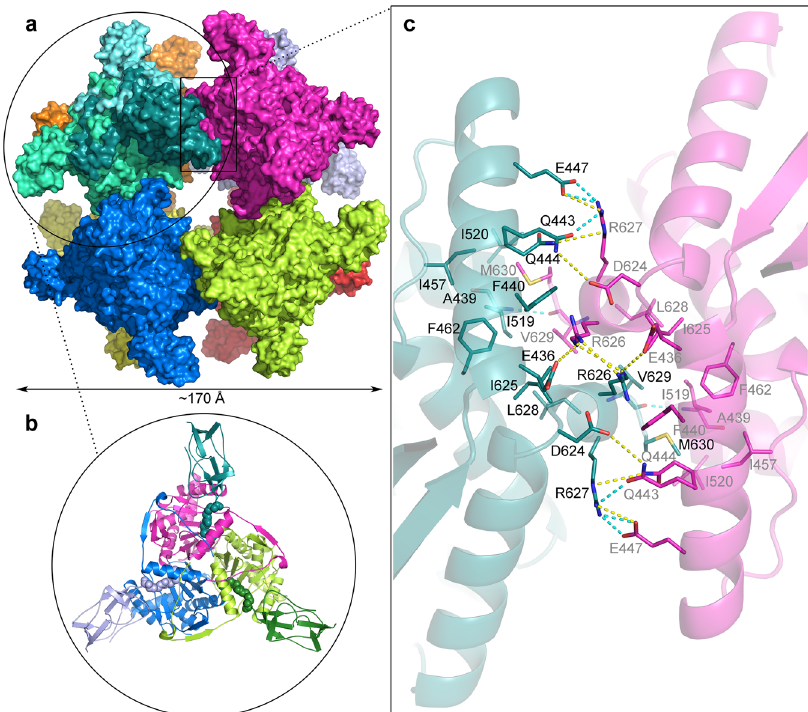
Fig. 2 Structure of the 24-mer of E. coli dihydrolipoyl transacetylase (E2p). a Surface representation of the overall structure of the E2p cubic core with each E2p trimer shown in a different color; E2p monomers in the top left E2p trimer are shown in different shades of cyan. b Cartoon structural representation of the E2p trimer. In the top E2p monomer the catalytic domain is colored magenta and the associated lipoyl domain in cyan with the dihydrolipoyllysine residue depicted as spheres, while in the other two E2p monomers the catalytic and lipoyl domains are colored in different shades of green and blue, respectively. c Molecular details of the contact interface between E2p trimers viewed along the two-fold axis. Interface residues located within the van der Waals distance are shown as sticks with residue numbers indicated for one E2p monomer (cyan) in black and for the second monomer (magenta) in gray. Pale cyan dashed lines represent hydrogen bonds and yellow dashed lines represent other polar